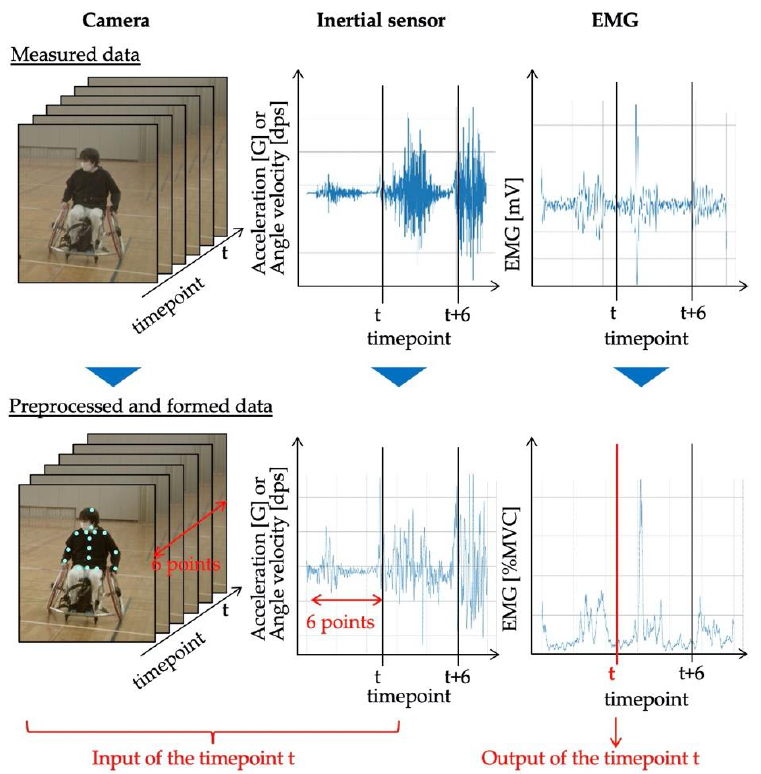
Figure 7. Sample data of the preprocessing and formation of datasets.